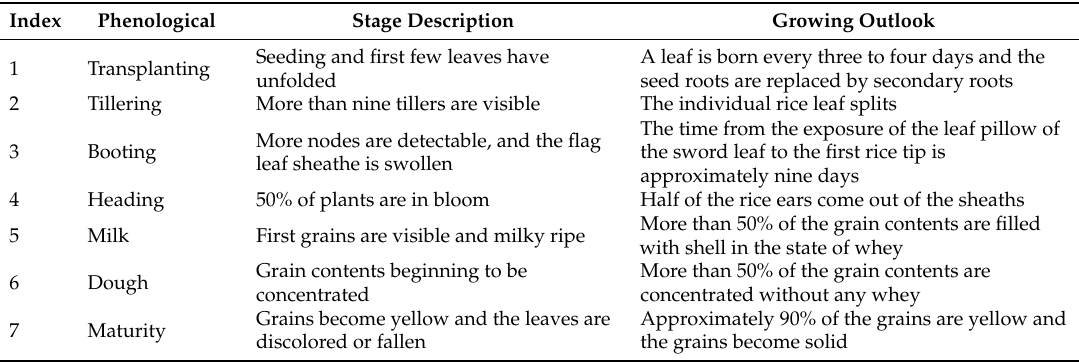
Table 2. The seven phenological stages for middle-season rice.